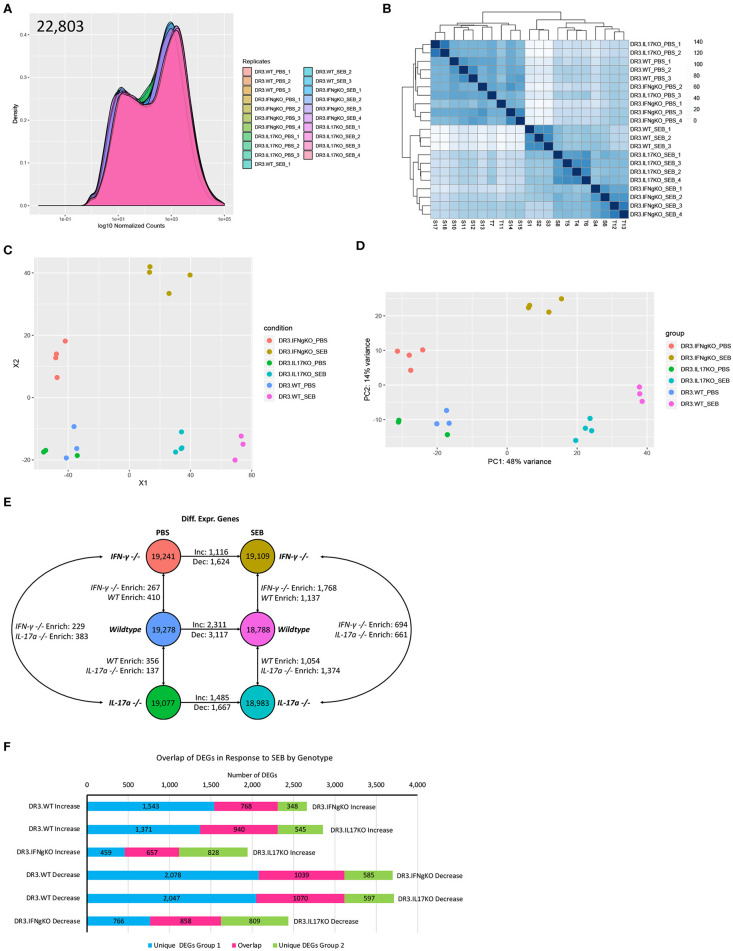
Analysis of global gene expression and differential expression in response to SAg-induced CRS. Genes with an expression value below 10 across all sample replicates were first excluded. (A) The distribution of gene expression across all sample replicates was determined for the filtered gene set. (B) Hierarchical clustering of samples based upon global filtered gene expression. (C) Multi-dimensional scaling and (D) principal coordinate analysis (PCoA) of global gene expression for each sample replicate. (E) Differential gene expression analysis for each experimental group. (F) Comparison of differentially expressed genes in response to SEB between genotypes. “Increase” indicates genes considered to be differentially expressed in an increasing manner (log2fold Δ >1, padj < 0.05) in response to SEB. “Negative” indicates genes considered to be differentially expressed in a decreasing manner in response to SEB (log2fold Δ >1, padj < 0.05).